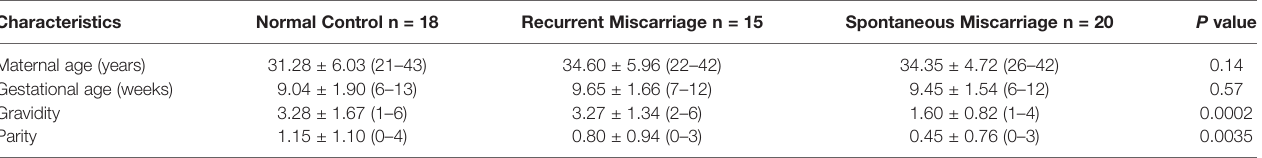
TABLE 1 | Demographic and clinical characteristics of the study population. Characteristics